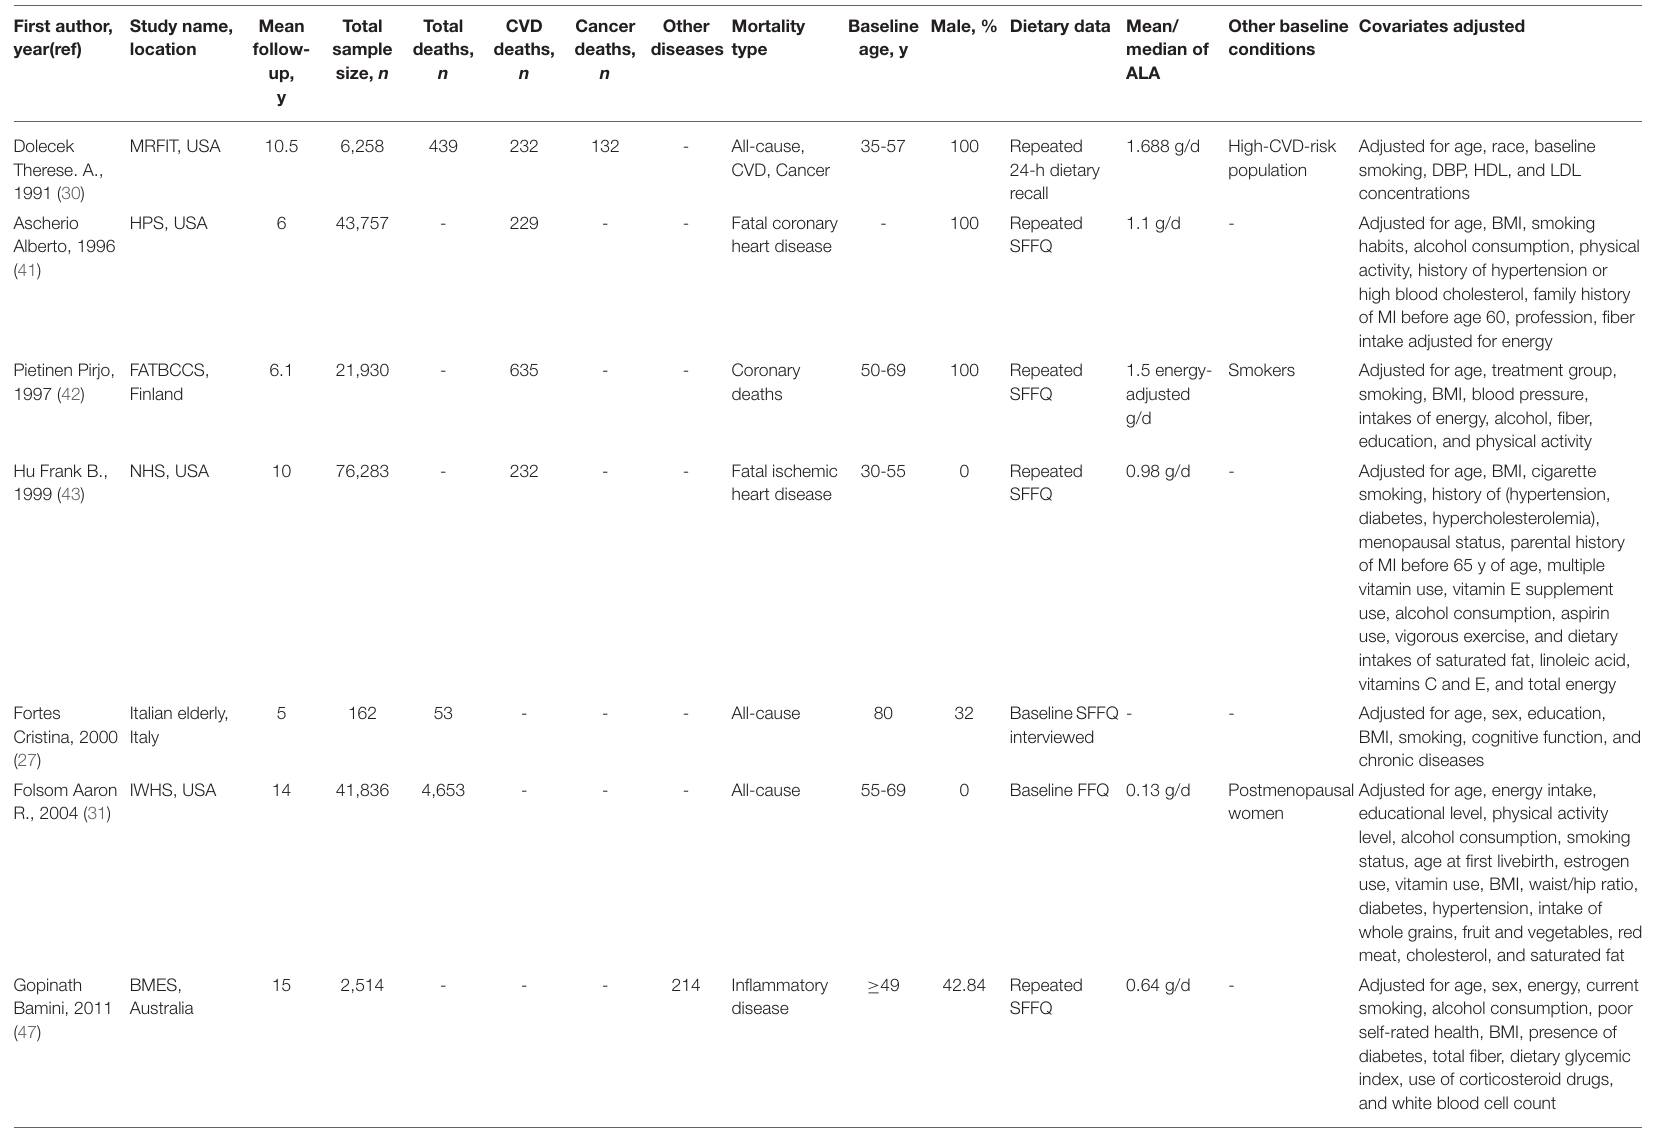
TABLE 1 | Characteristics of prospective cohort studies that evaluated the association between dietary α - linolenic acid (ALA) intake and mortality from all-cause, cardiovascular disease (CVD) and other